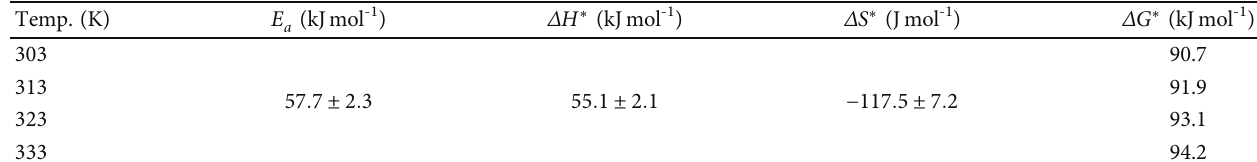
Table 2: Activation parameters for the adsorption of BF on GC.